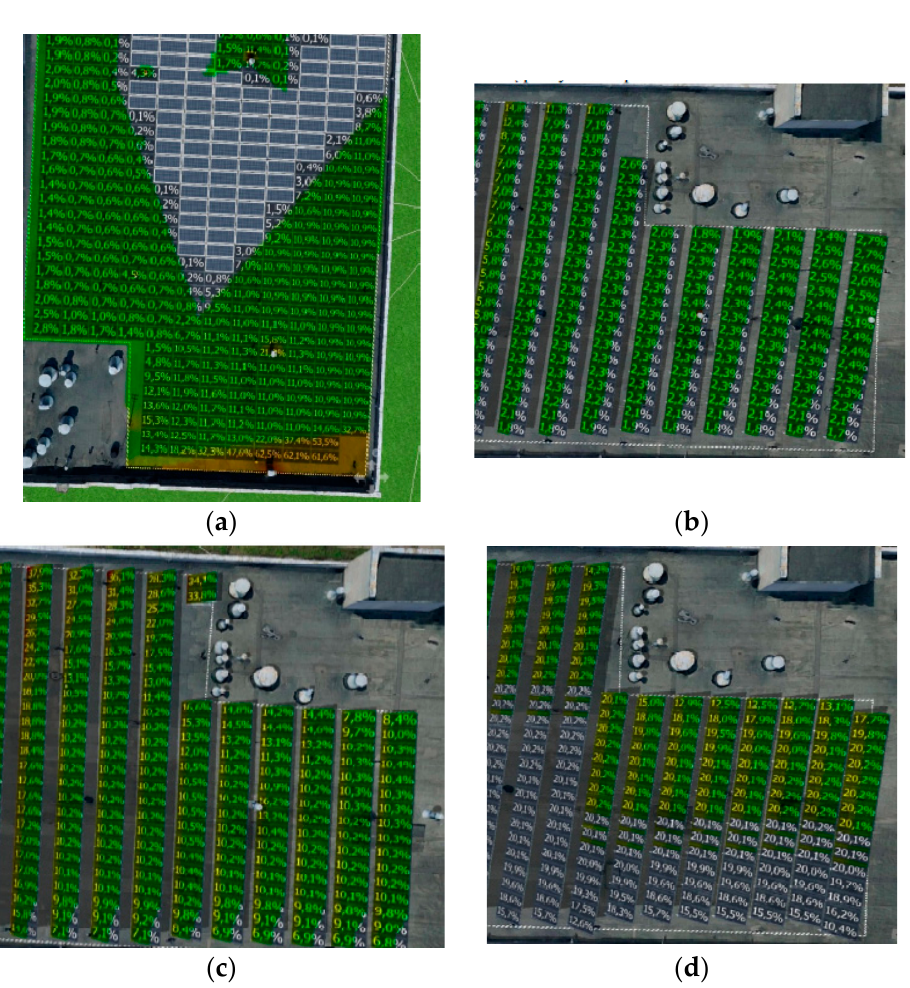
Figure 3. Shading durations at different tilt angles: ( a ) 0 ◦ , ( b ) 15 ◦ , ( c ) 30 ◦ , and ( d ) 45 ◦